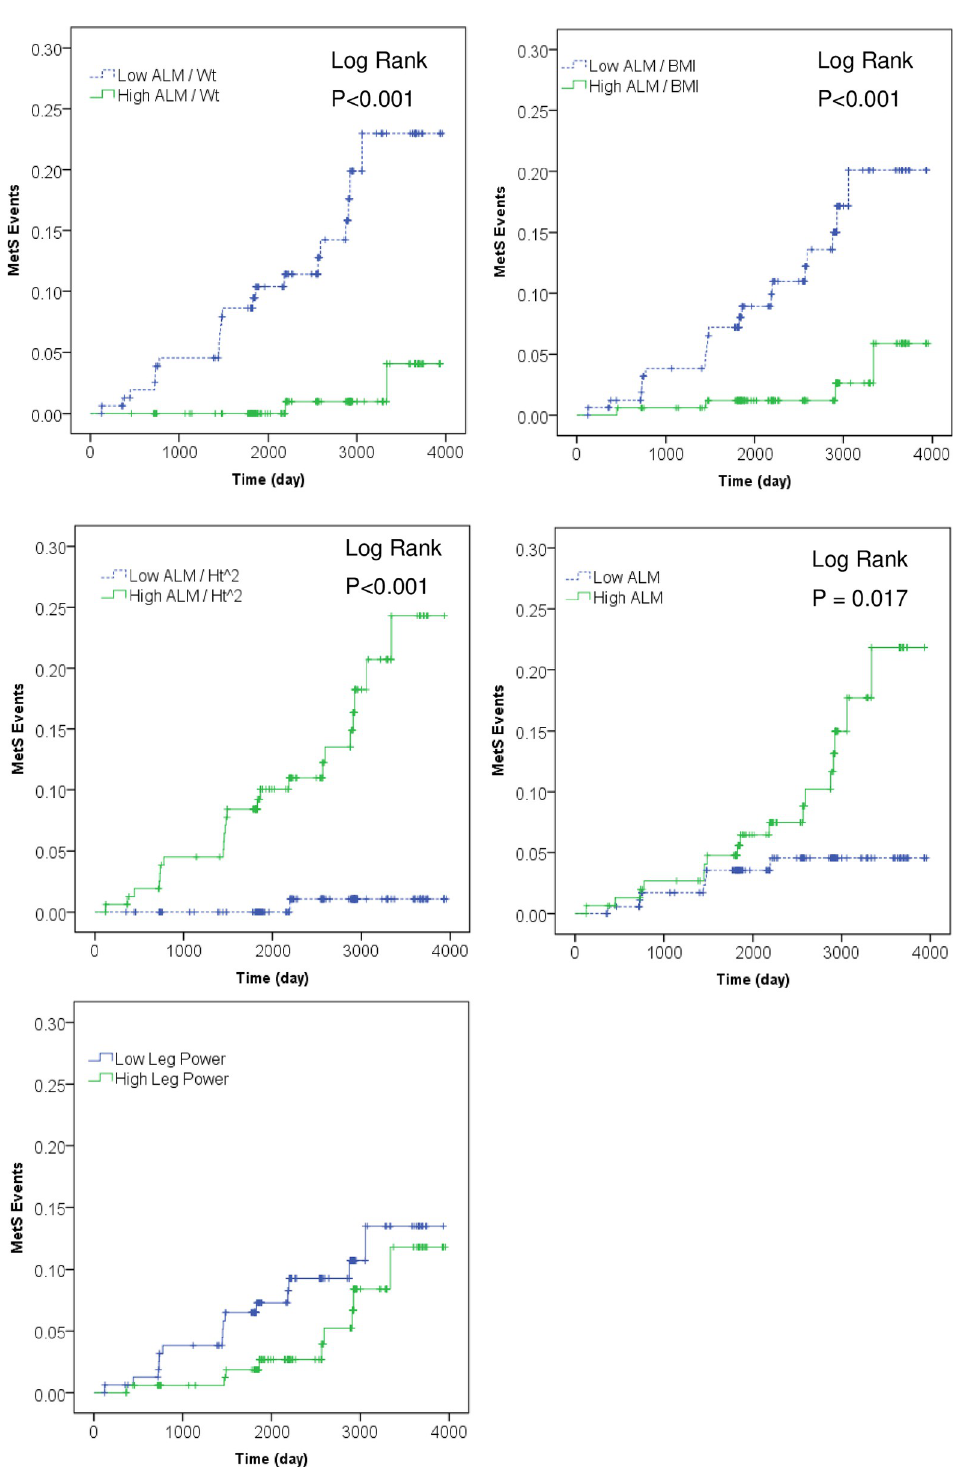
Fig 1. Kaplan-Meier curves for events of incident metabolic syndrome (MetS). Bold green line shows High ALM indices group, and dashed blue line shows Low ALM indices group.